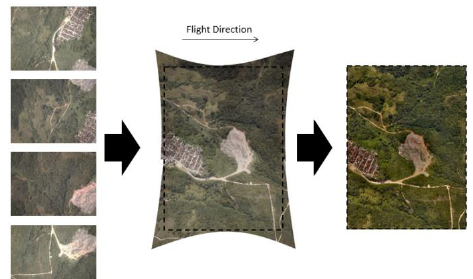
Figure 5. The synthetic image generation process. (Ercolin Filho et al., 2017)